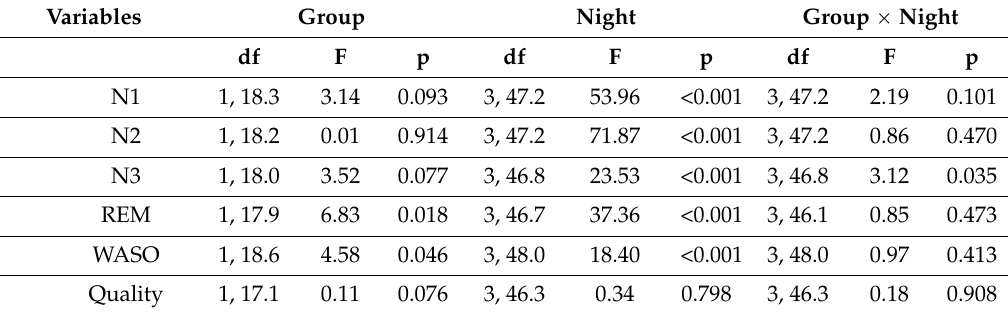
Figure 1. Sleep Variables. Mean ± Standard error or measurement (SEM) for TST, Efficiency, Arousals/h, WASO, N3, REM, SOL, Subjective Sleep Quality for the two groups: SDB, non-SDB and across the 4-nights: Baseline (BL), Experimental Night 1 (E1), Experimental Night 2 (E2) and Recovery (R).